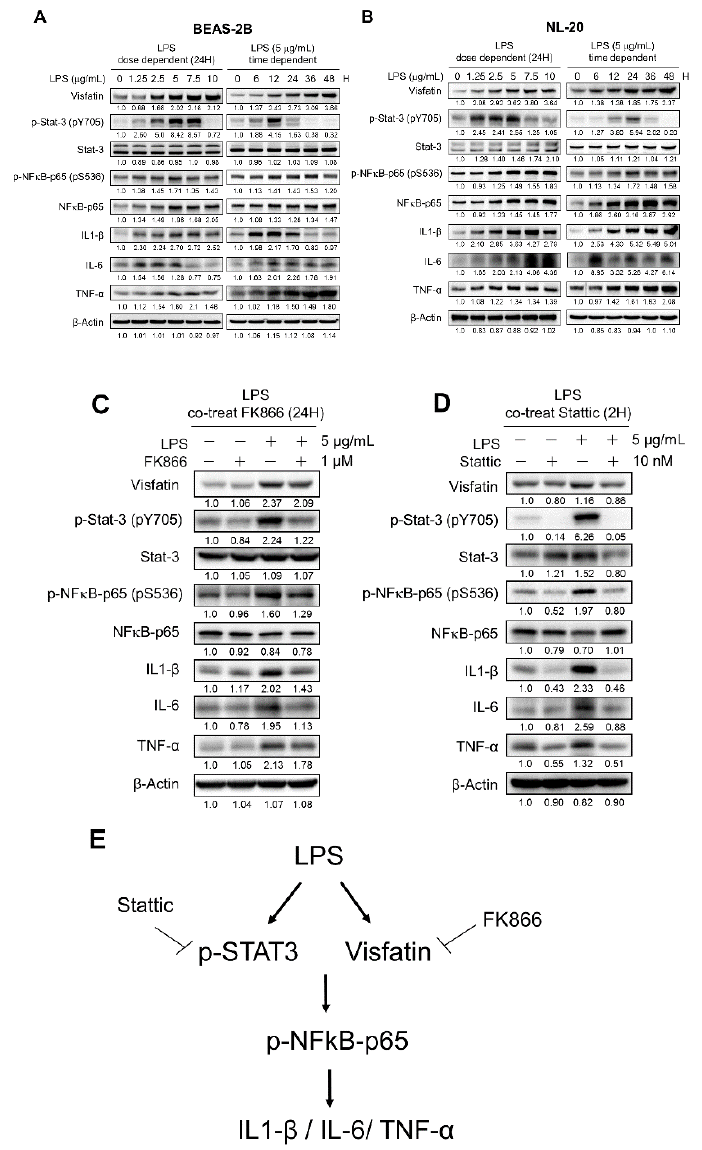
Figure 4. Visfatin increased the expression of pro-inflammatory cytokines through STAT/NF- κ B pathway in human bronchial epithelial cells. ( A , B ) Dose- and time-dependent effects of LPS on the expression of visfatin, STAT3, NF κ B, and pro-inflammatory cytokines in human bronchial epithelial cell lines BEAS-2B and NL-20. ( C ) Co-treatment of FK866 and LPS on the expression of visfatin, STAT3, NF κ B, and pro-inflammatory cytokines. ( D ) Co-treatment of STAT3 inhibitor static and LPS on the expression of visfatin, STAT3, NF κ B, and pro-inflammatory cytokines. ( E ) Schematic representation of the LPS-induced signaling pathway in human bronchial epithelial cells.